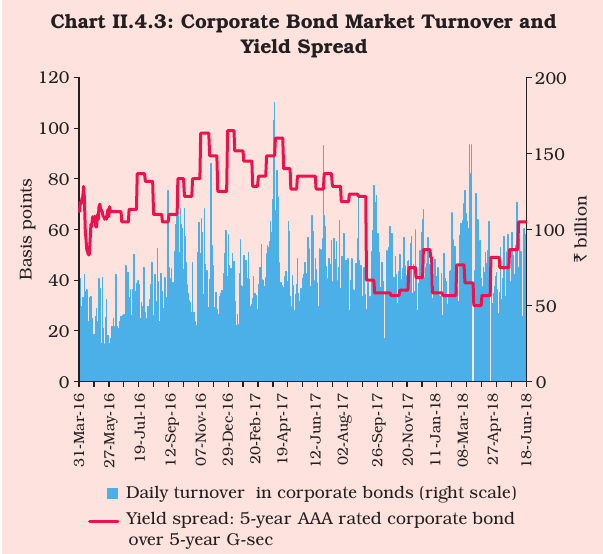
Chart II.4.3: Corporate Bond Market Turnover and Yield